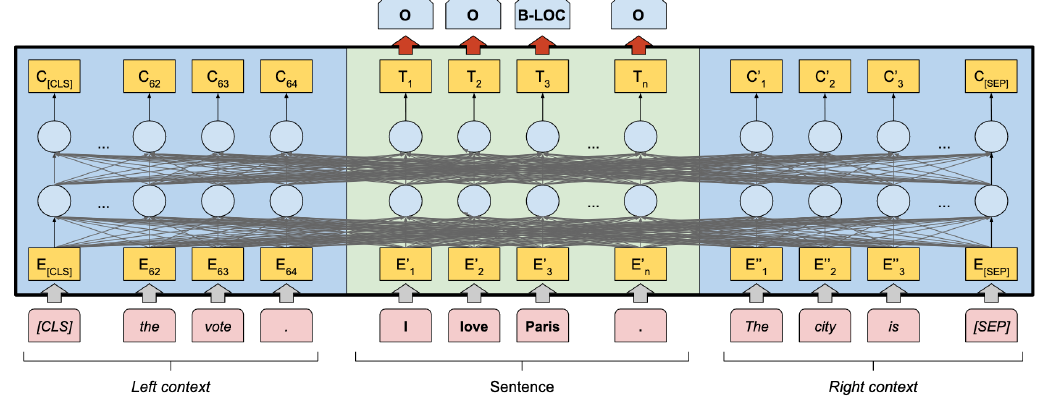
Figure 2. The FLAIR model architecture [37] for document‑level